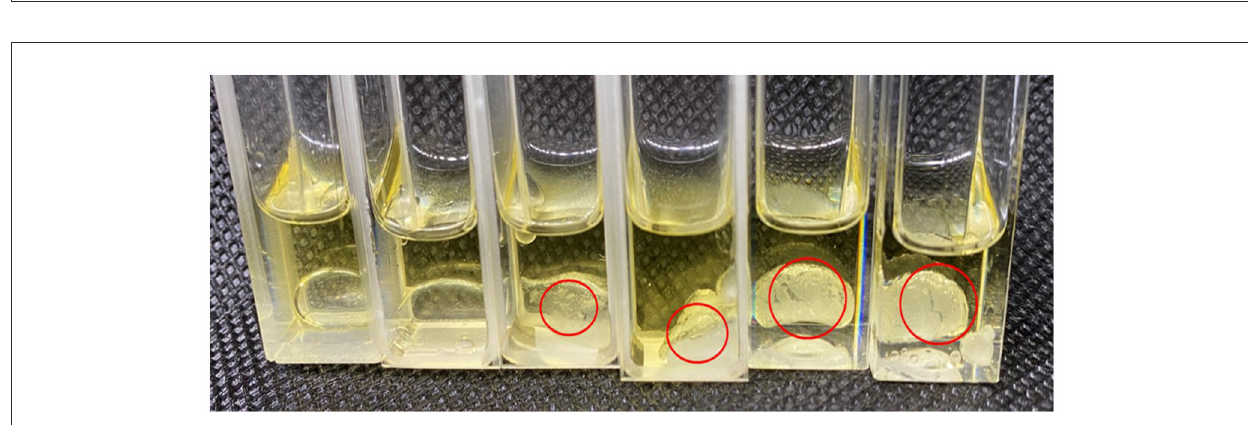
FIGURE8 Formation of interface film (From left to right: 0.2mL deionized water, 0.3125 wt%, 0.625 wt%, 1.25 wt%, 2.5 wt%, and 5 wt% of β -CD solution were added to 1mL GO).